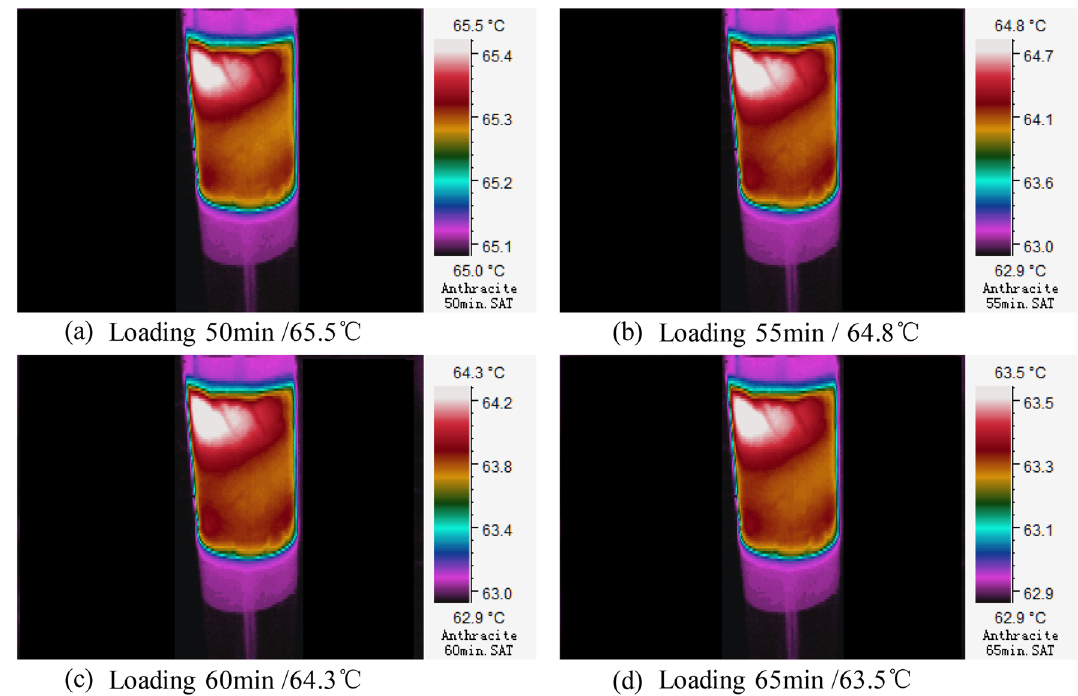
Figure.7. Three-dimensional infrared cloud maps of slow cooling